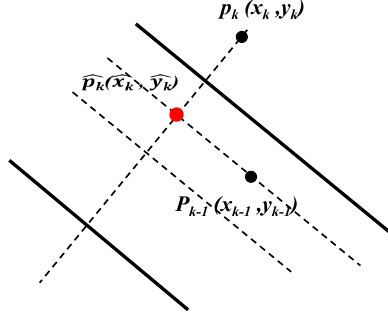
Figure 11. Map boundary restriction. Map restriction scheme for the positioning results that need to be corrected. P k − 1 is the final positioning result at k − 1, P k is the centroid coordinates of the triangle determined by the trilateral centroid positioning algorithm at k , and (cid:98) p k is the corrected positioning